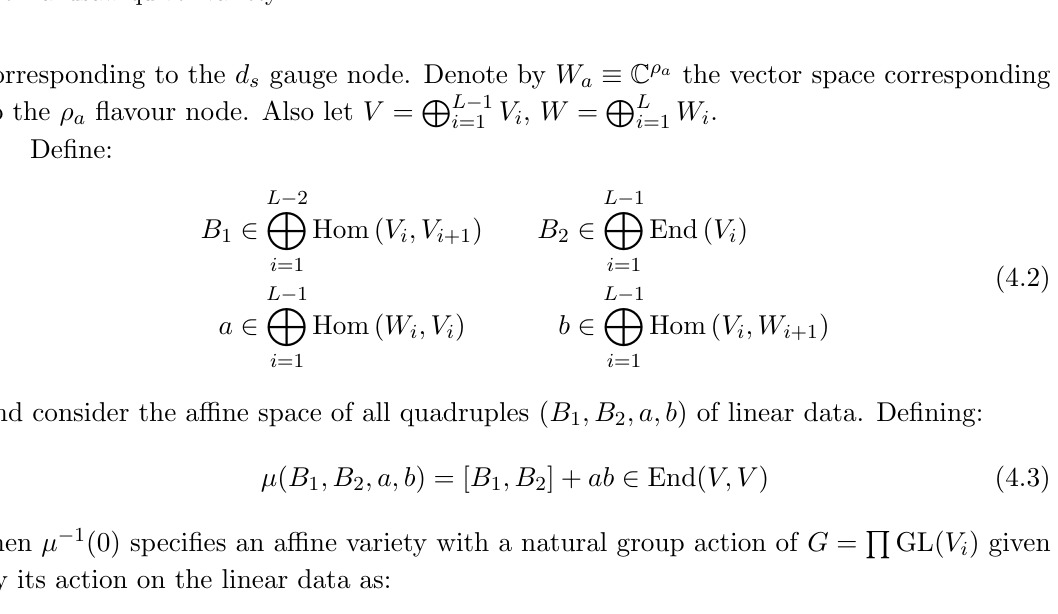
Figure 3 . The quiver diagram for the 3d N = 4 T (cid:26) [SU( N )] theory and its vortex moduli space; the Handsaw quiver